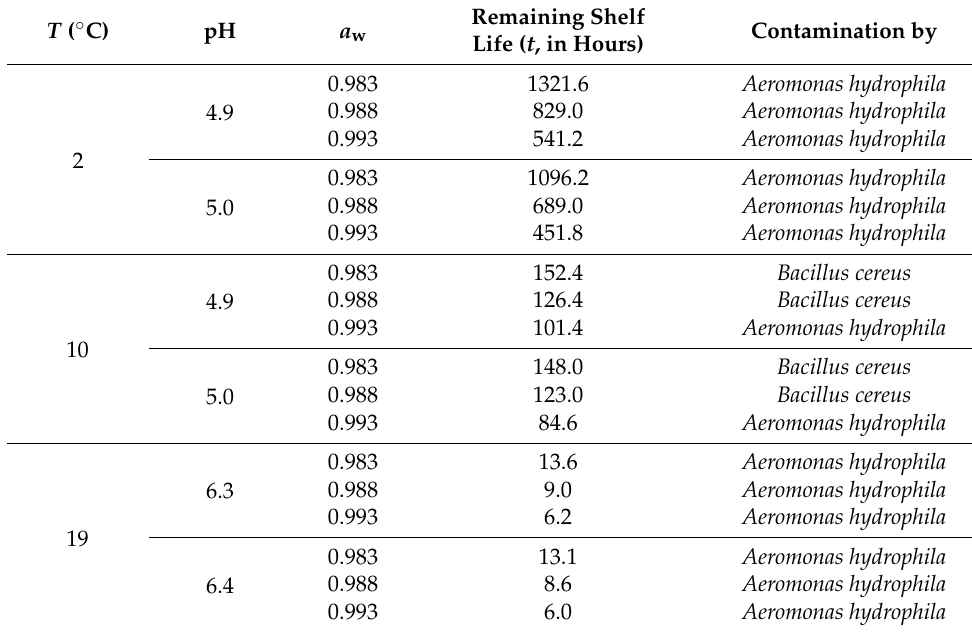
Table 8. Sampling of results of DSS—Remaining shelf life of